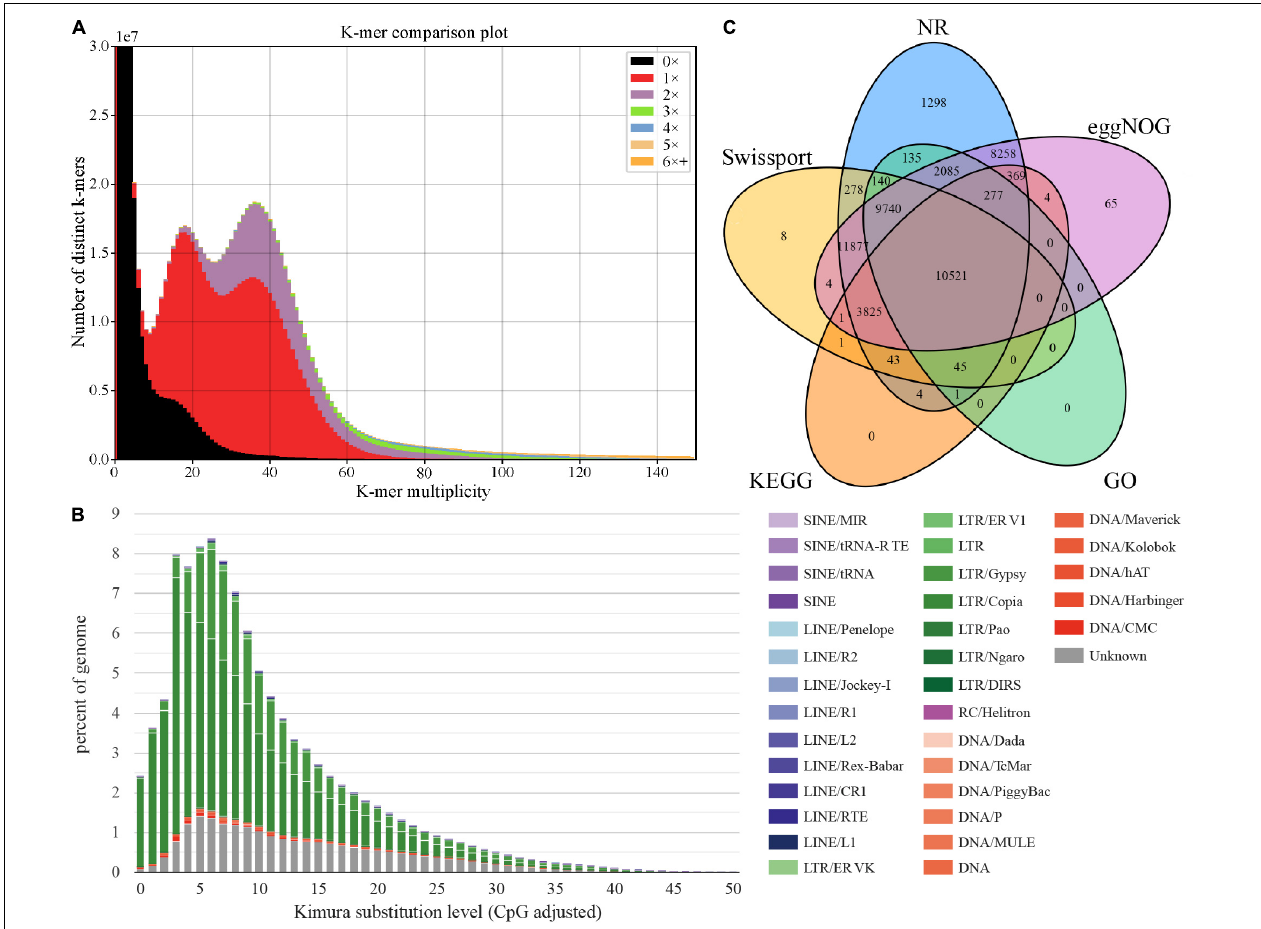
FIGURE 2 | Genome size assessment and function annotation. (A) K -mer spectra between WGS (whole-genome sequencing) and the assembly. (B) TE expansion patterns of A. tsao-ko . (C) Venn diagram for functional annotation of genes in different